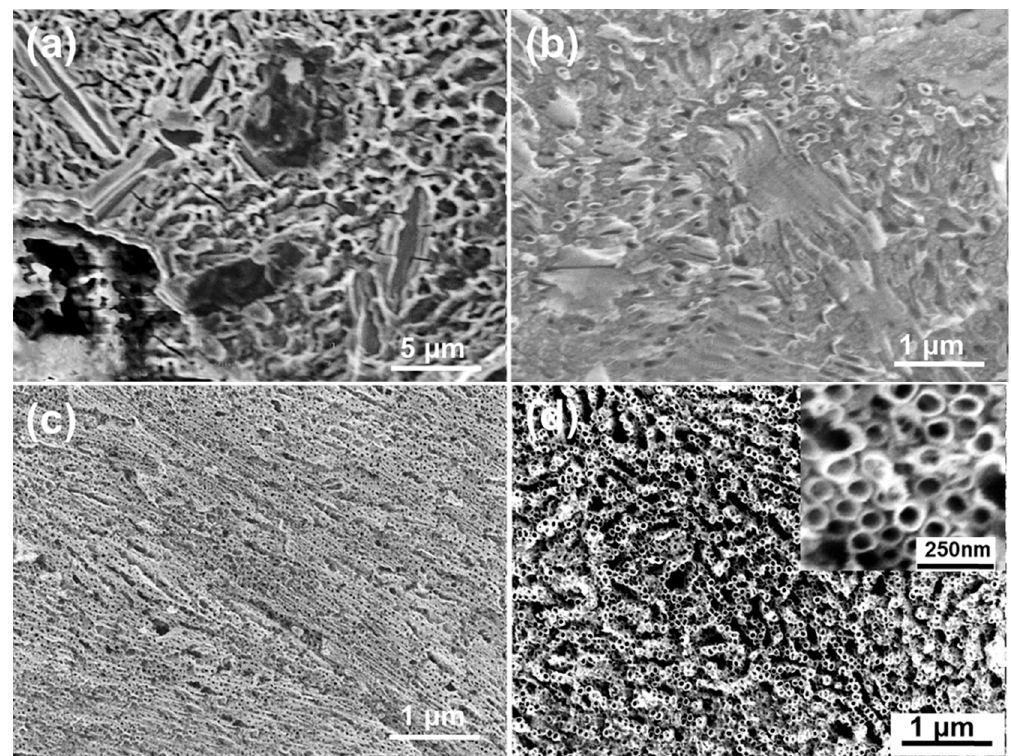
Figure 3. Top-view SEM images of the anodic oxide layer obtained from different electrolytes. ( a ) EL-1, ( b ) EL-2, ( c ) EL-3 and ( d ) EL-4. The anodization was performed at 30 V for 90 min.